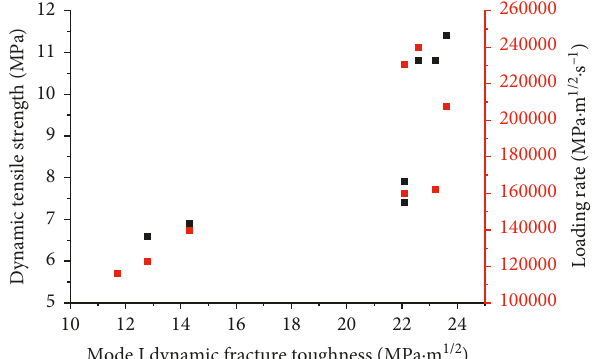
Figure 7: Relation between dynamic fracture toughness and dynamic tensile strength of 510m.